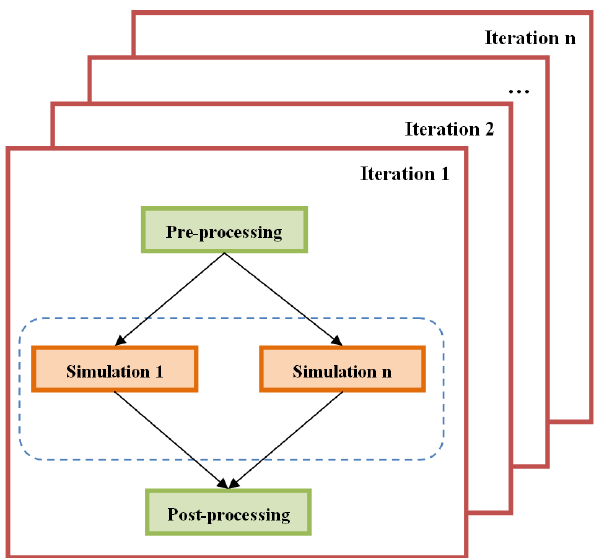
Fig. 2. SWAT model calibration process.